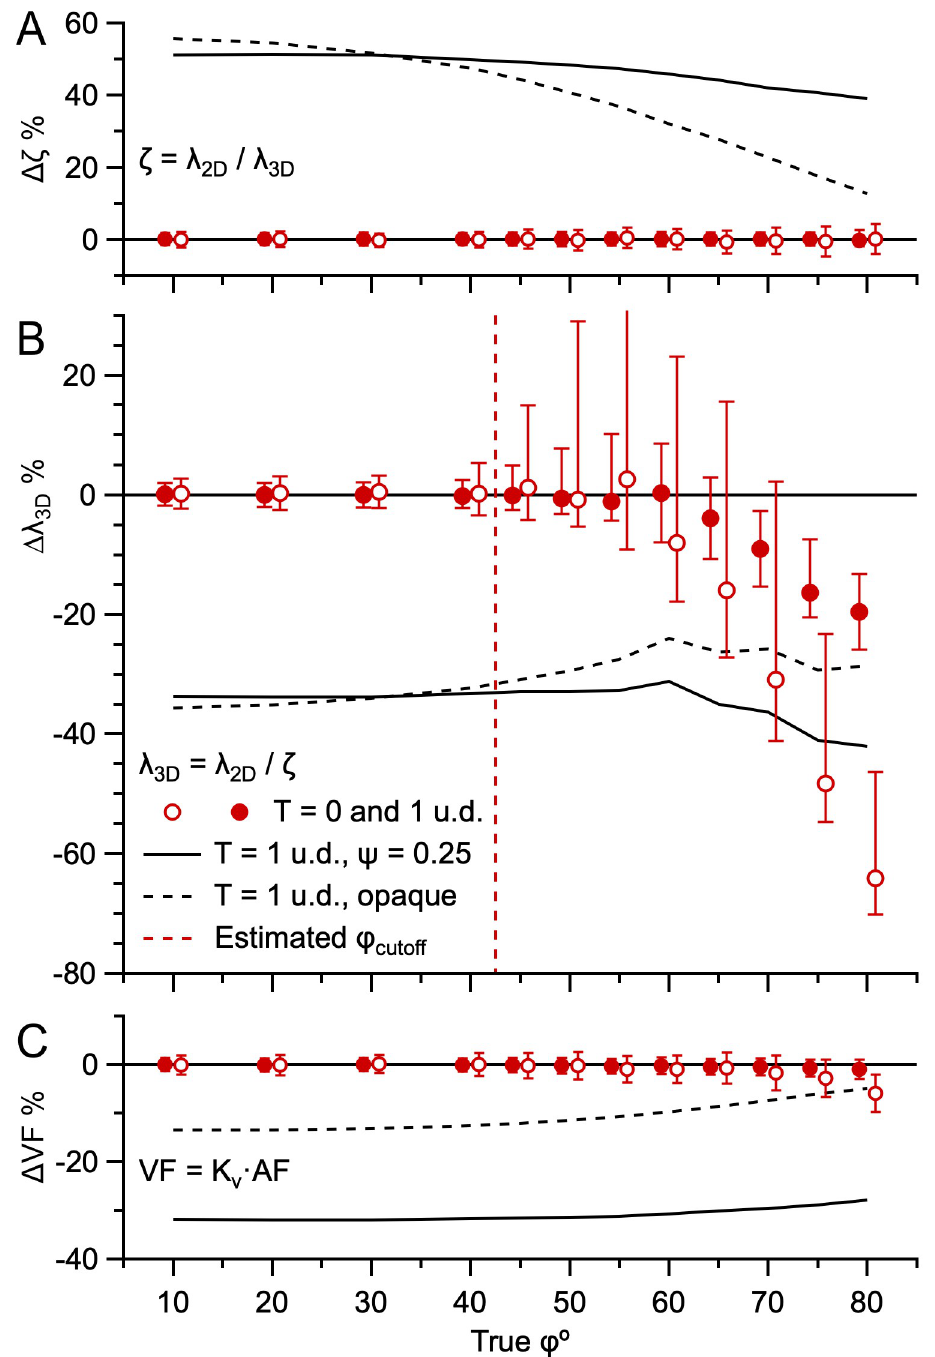
Fig 10. The Keiding model accurately estimates λ 3D from λ 2D for true ϕ < estimated ϕ cutoff (simulations). A. Average error in section z-depth over which particle center points are sampled ( Δ z ) vs. true ϕ (top) for simulations in Fig 4C for T = 0 and 1 u.d. (red open and closed circles) where estimated z was computed via Eq 2 using true μ D , ϕ and T and ‘true’ z = λ 2D / λ 3D using measured λ 2D and true λ 3D . B. Average error in 3D particle density ( Δλ 3D ) vs. true ϕ (middle) for the same simulations, computed via estimated and true λ 3D , where estimated λ 3D was computed via Eq 3 ( λ 3D = λ 2D / z ) using measured λ 2D and estimated μ D and ϕ from Keiding-model fits to the simulated G(d). Red dashed line denotes estimated ϕ cutoff (~43˚; Eq 9). One error bar at true ϕ = 55˚ is off scale (+56%). C. Average error in volume fraction ( Δ VF) vs. true ϕ (bottom) for the same simulations, computed via estimated and true VF, where